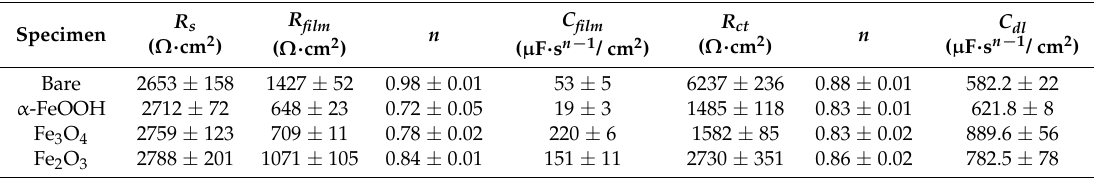
Table 4. Impedance parameters of bare specimen and iron oxides ( α -FeOOH, Fe 3 O 4 and Fe 2 O 3 ) -covered specimens in the simulated district heating water at 40 ◦